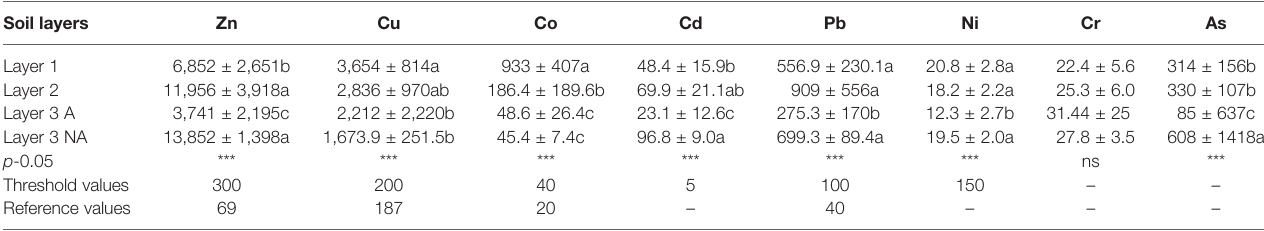
TABLE 3 | Pseudo-total metal concentrations of soil layers at the amended holes in the tailings dam (mg kg − 1 , n = 10). Soil layers